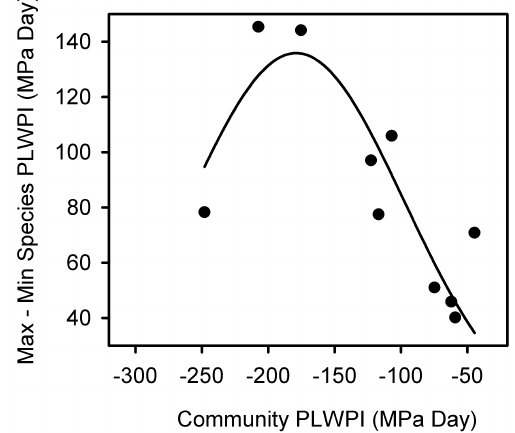
Figure 3. Seasonal variations in predawn leaf water potential of different species from 2010 to 2013.